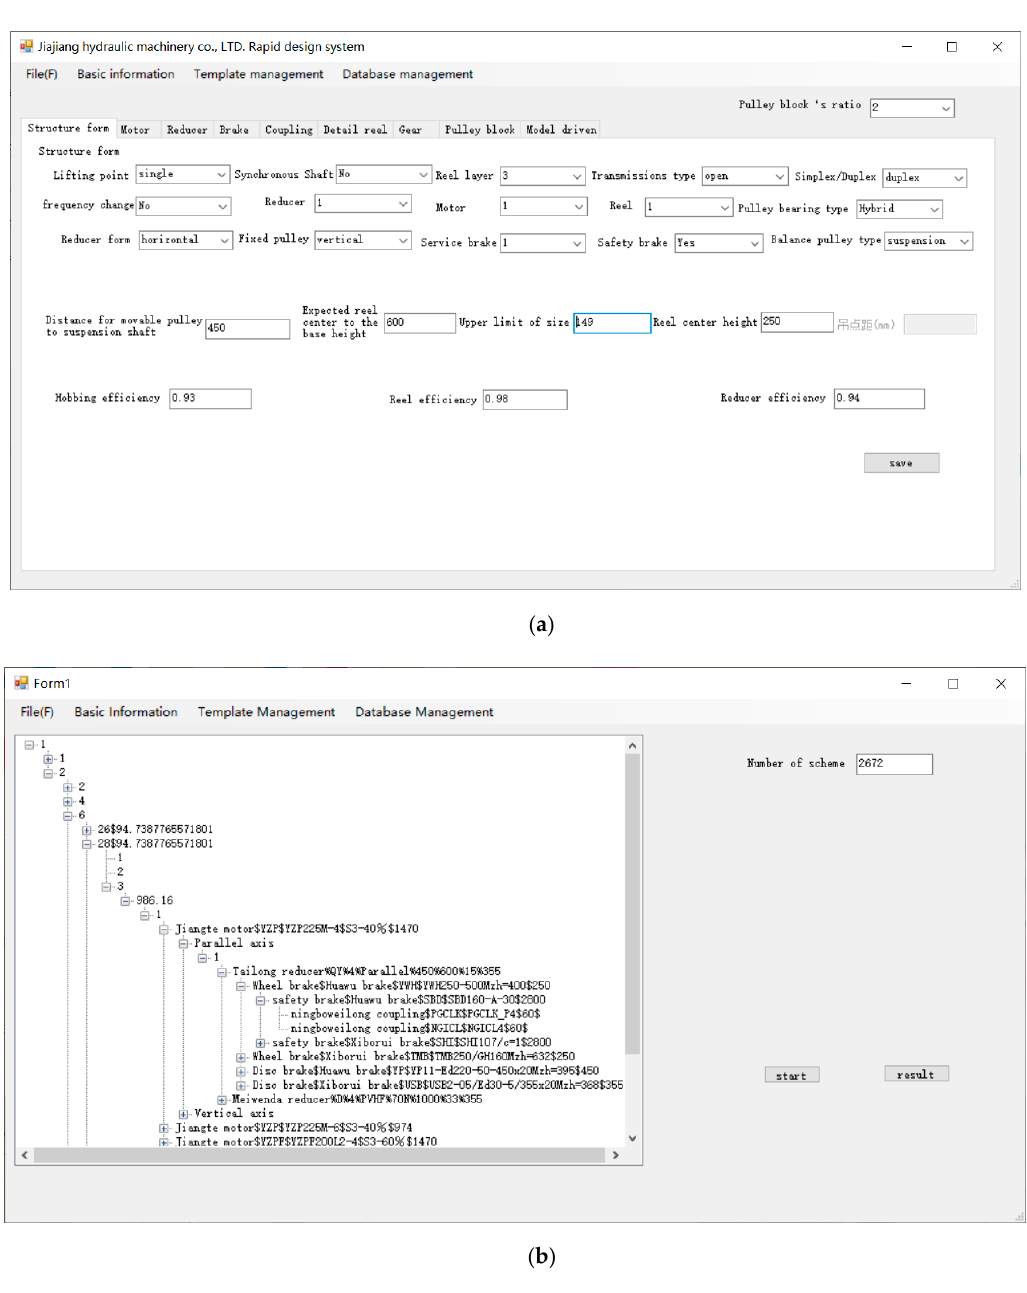
Figure 7. Design system of hoist. ( a ) Current design method system. ( b ) The improved design system.